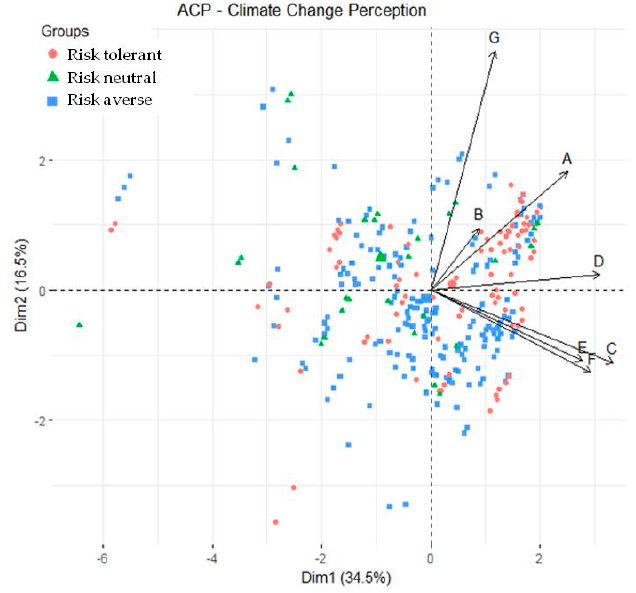
Figure 4. Distribution of farmers according to their perceptions of climate change. ( A ) Impact of global warming on their crops; ( B ) Percentage of climate change influence on production costs; ( C ) Temperature increase; ( D ) More episodes of floods; ( E ) More episodes of hail; ( F ) More diseases and pests; ( G ) Changes in weed development.